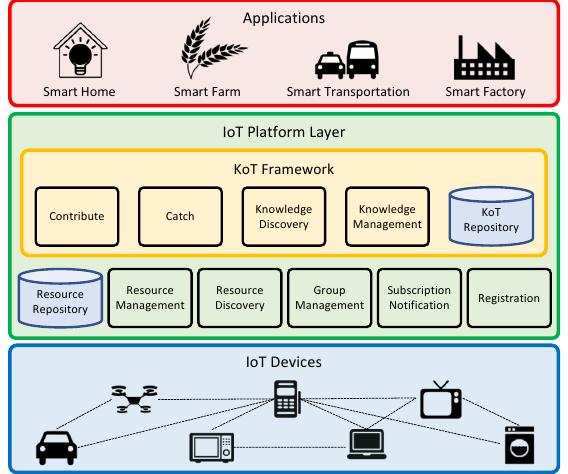
Figure 2. Architecture of the KoT Framework integrated into the IoT platform layer.